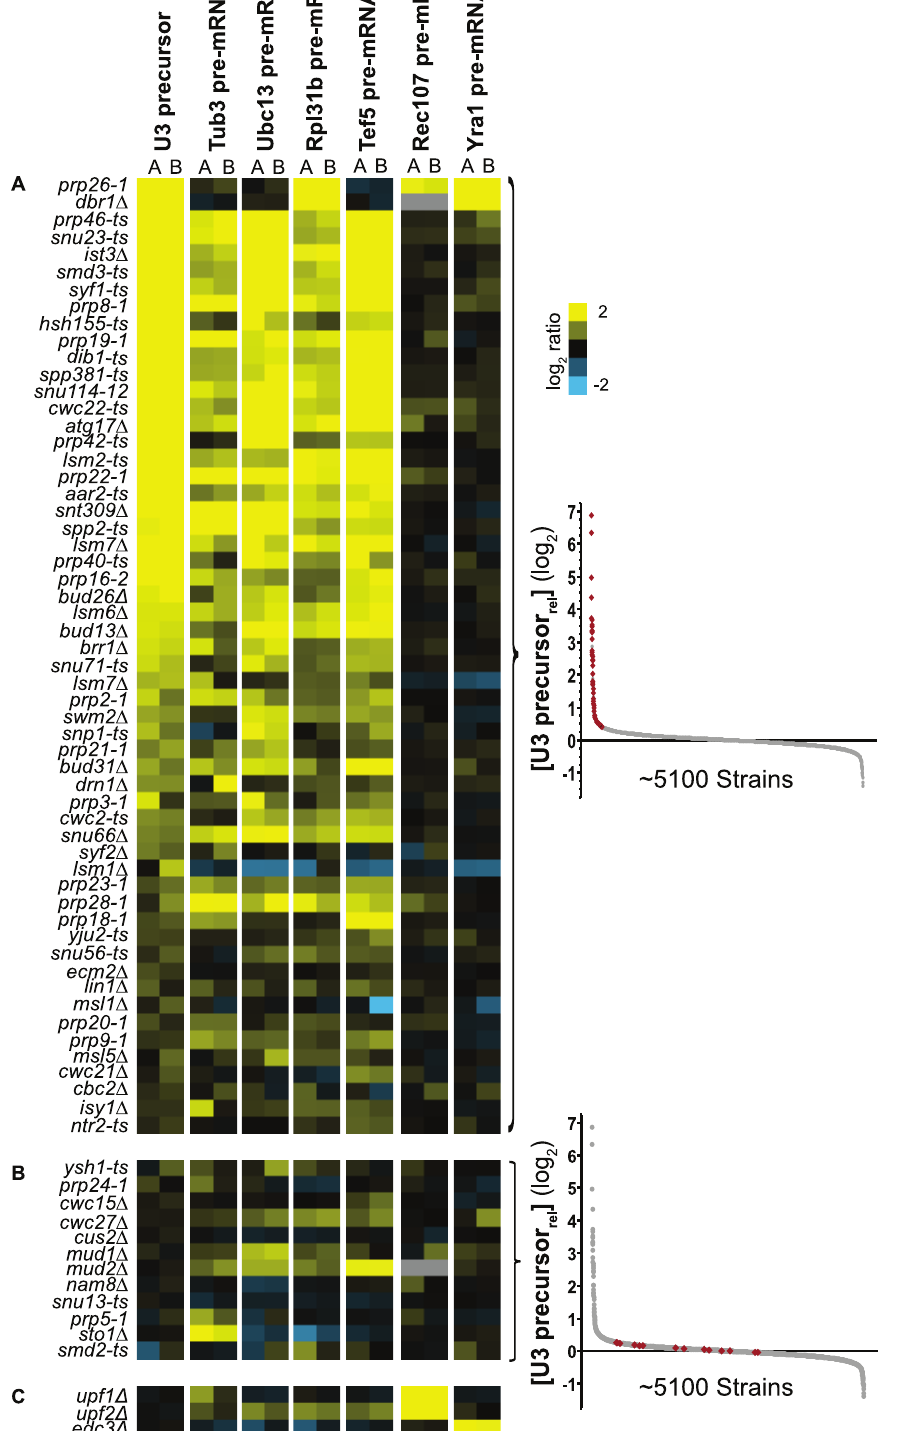
Figure 3. Mutations in most known splicing factors lead to increased precursor levels of canonical splicing substrates. Relative levels of the indicated RNAs are shown in the background of all strains containing mutations in known splicing factors. The biological replicates (A and B) are shown for each RNA. Precursor levels for all transcripts are ordered based on the average expression values of U3 precursor, from high to low values. Gene disruptions are indicated on the left ( -ts indicates a temperature sensitive allele). Insets to right indicate the location of the data in the U3 precursor dataset. A. Mutations that lead to an increase in the U3 snoRNA. B. Mutations that do not affect U3 precursor levels but may affect the levels of other intron containing genes. C. The increase of Rec107 precursor levels seen in the ufp1 D and upf2 D backgrounds, and the increase of Yra1 precursor levels seen in the edc3 D background are consistent with their well-characterized degradation pathways. doi:10.1371/journal.pgen.1002530.g003 PLoS Genetics |